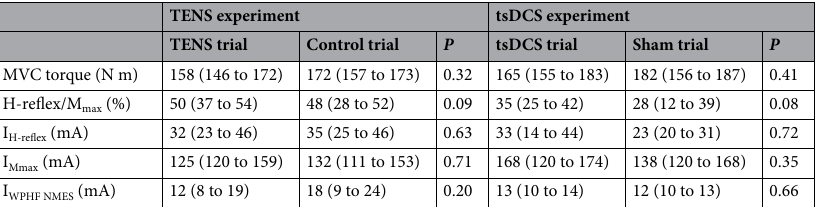
Table 1. Baseline variables in the TENS and tsDCS experiments. Values are median (25th percentile to 75th percentile). TENS transcutaneous electrical stimulation, tsDCS transcutaneous spinal direct current stimulation, MVC maximal voluntary contraction, H-reflex H-reflex peak-to-peak amplitude, M max maximal M-wave peak-to-peak amplitude, I H-reflex stimulation intensity used to elicit a maximal H-reflex, I Mmax 120% of stimulation intensity used to elicit a maximal M-wave, I WPHF NMES wide-pulse, high-frequency neuromuscular electrical stimulation (WPHF NMES)